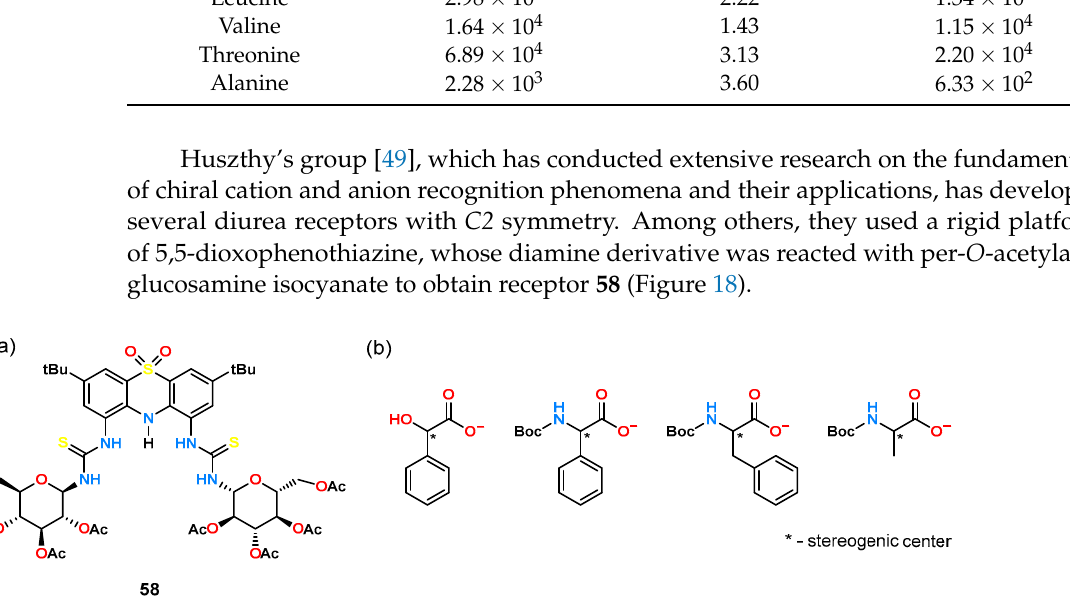
Figure 18. ( a ) Phenothiazine diurea receptor 58 and ( b ) evaluated hydroxy and amino acids.